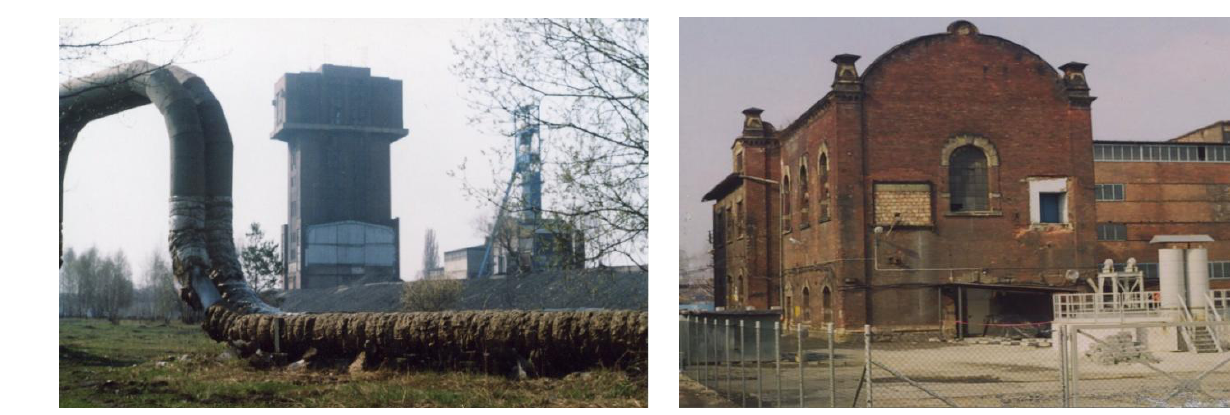
Fig. 3. Winding towers in the closed “Szombierki Coal Mine” in Bytom: “Krystyna” (brick construction) and “Janina” (steel construction) ( M. Lamparska )